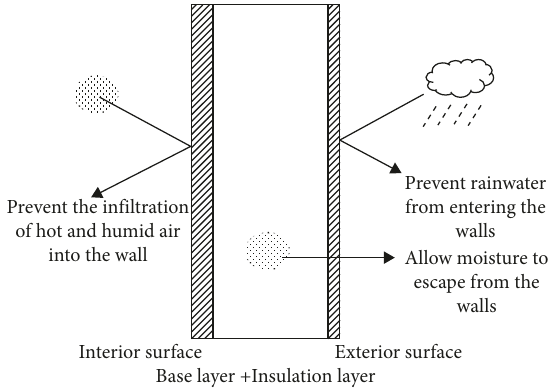
Figure 1: Design principles for water tightness and air permeability of low-energy exterior wall